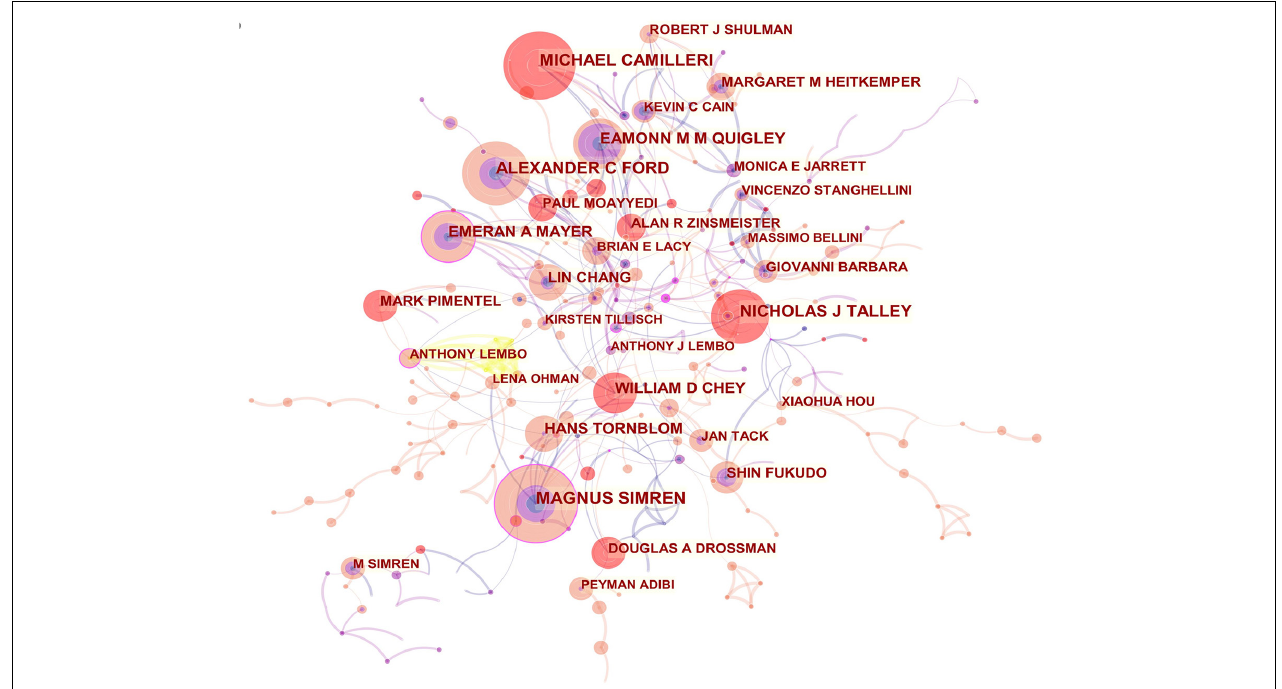
FIGURE 4 | Network of authors in IBS